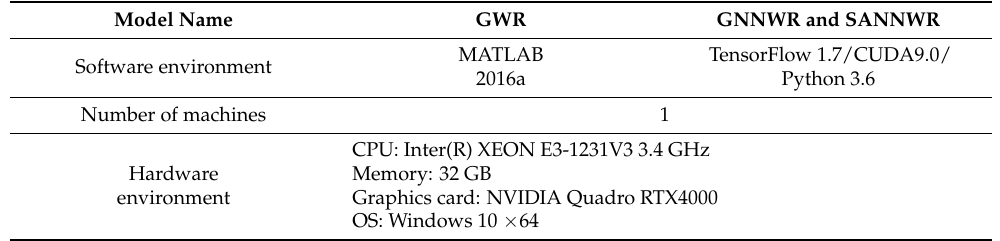
Table 5. Software and hardware environment of these